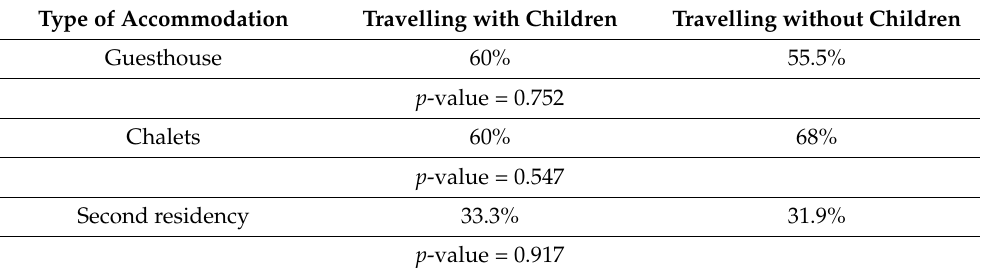
Table 3. Analysis of accommodation type used based on type of tourist group.